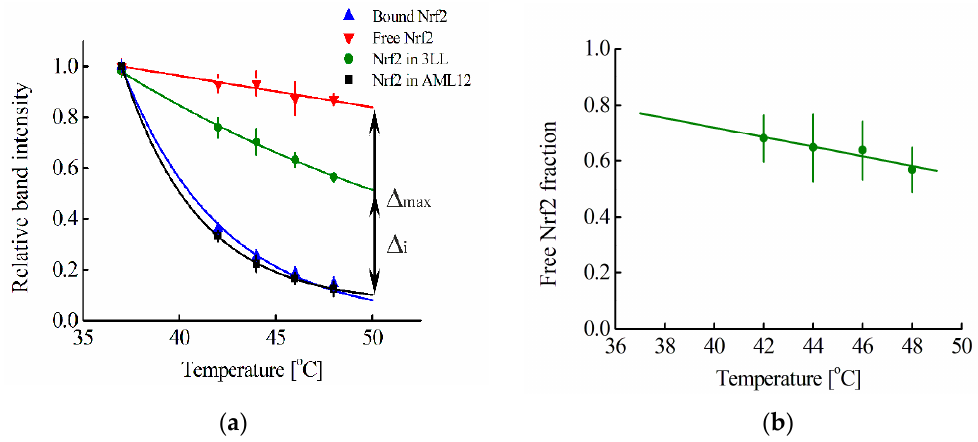
Figure 2. ( a ) Melting curves averaged over Hepa1, MEF, and RAW264.7 cell lines of free Nrf2 and Nrf2 bound to Keap1 and total Nrf2 in 3LL and AML12 cell lines. The dependences are normalized to the band intensity at 37 °C; ( b ) Dependence between free Nrf2 fraction ( ∆ i / ∆ max ) in 3LL cells and temperature. The green line shows the linear extrapolation of experimental data to 37 °C. Standard errors (SE) are shown ( n = 4–12).